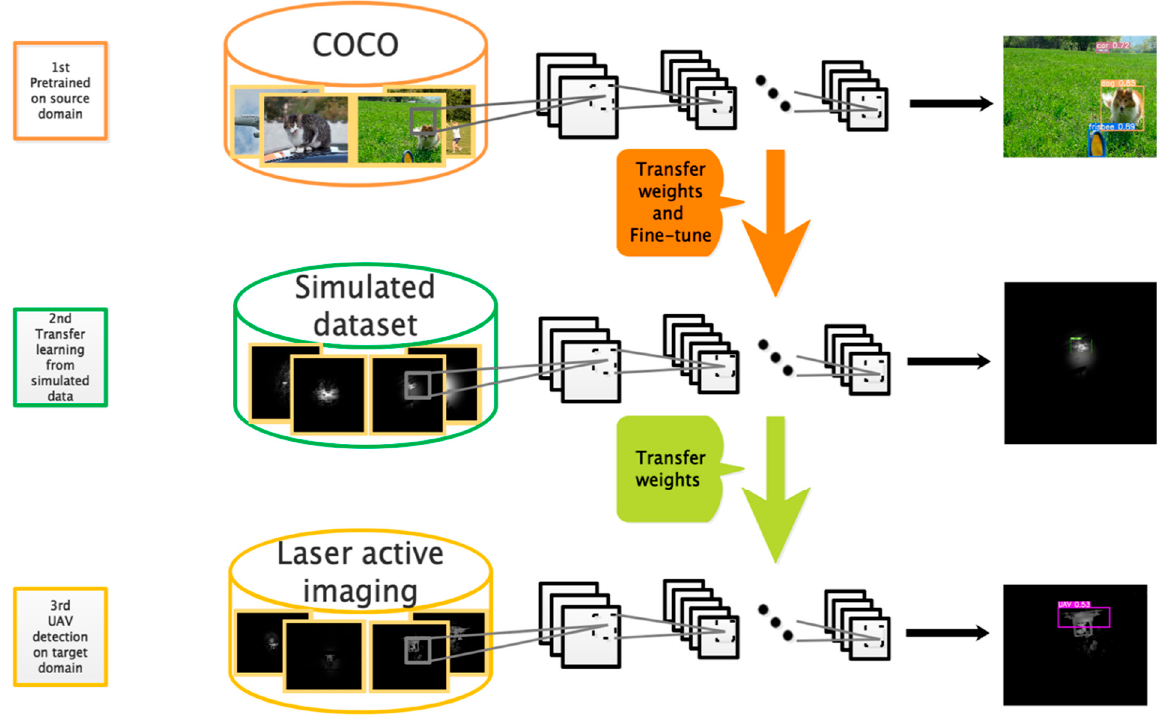
Figure 1. The flowchart of the proposed method. First, the model was pre-trained on the source domain. Second, the model was fine-tuned on the simulation dataset. Third, the model detected UAV in the target domain.